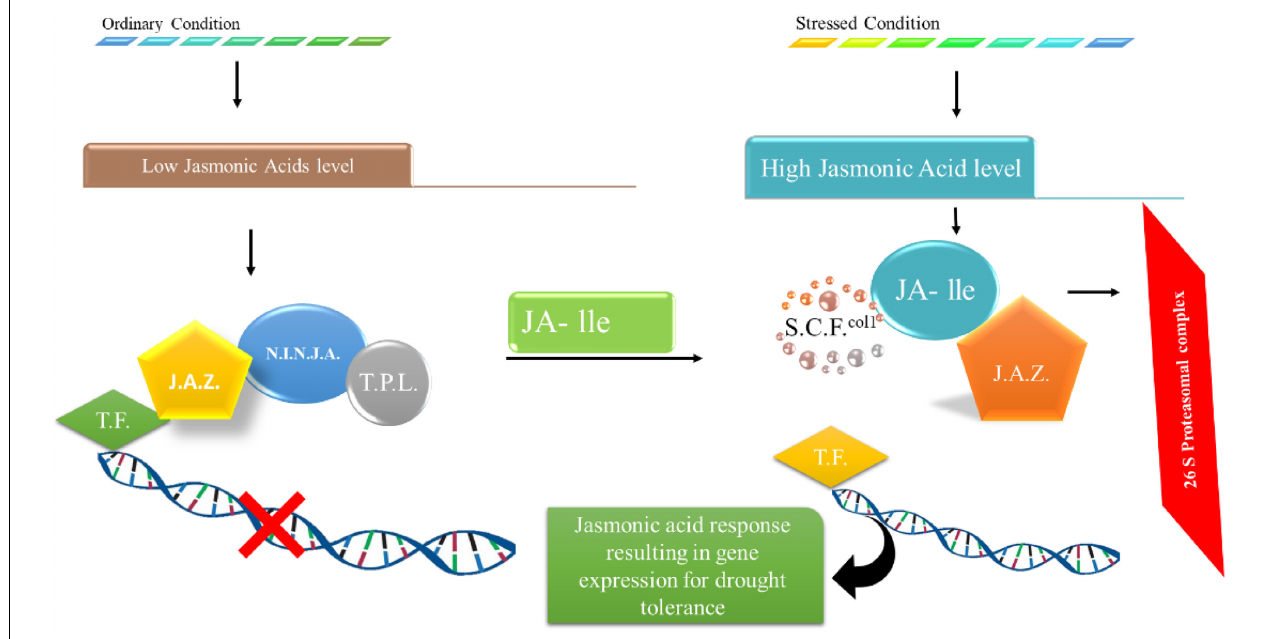
FIGURE 5 | Changes in JA signals under stressful situations. JAI3/JAZ proteins attach to different transcription components and restrict their function along with reduced levels of JA under ideal circumstances. The JA concentrations are high and deteriorate JAZ proteins under stressful situations, leading to the activation of transcriptional components that upregulate genes associated with stress